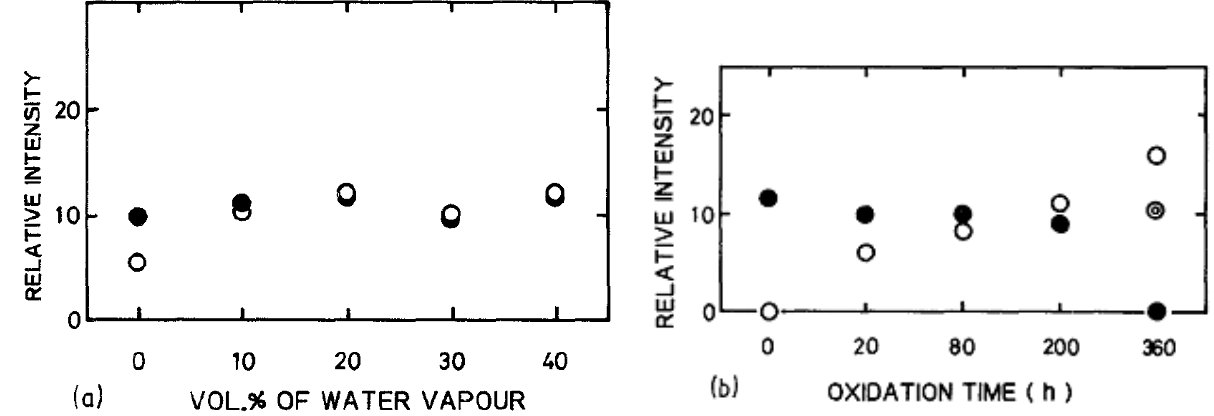
Figure 19. Relative intensities of X-ray diffraction peaks ( a ) against water vapor content (1300 °C, 100 h) and ( b ) against oxidation time (1300 °C, 20 vol% H 2 O), (•) corundum, (o) cristobalite and ( ) mullite. Reprinted with permission from Reference [74]. Copyright 1988 Springer Nature.